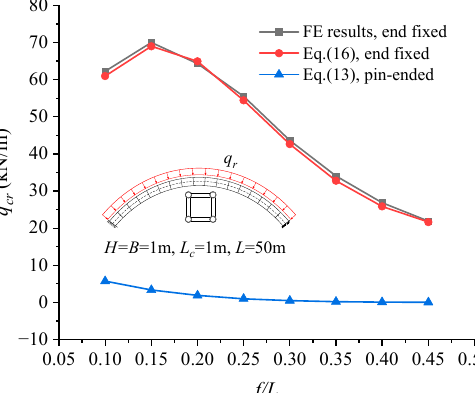
Figure 10. Comparison of buckling loads between FE and theoretical results for the end-fixed Vierendeel truss arches with different rise-to-span ratios.